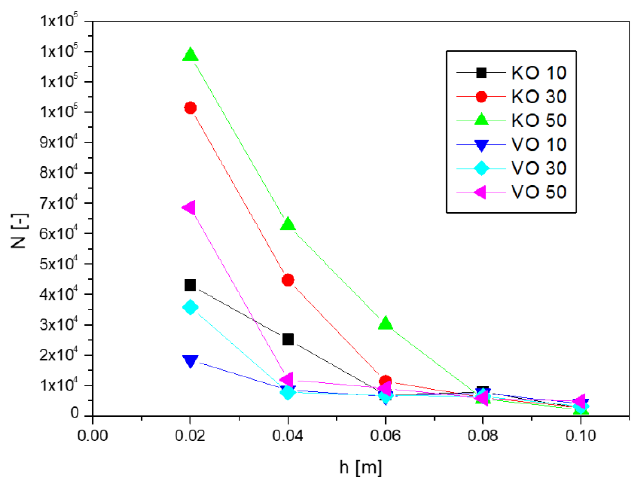
Figure 6. Dependence of the number of drops per 1 mL of porous material on the imbibition height for the studied emulsion systems.